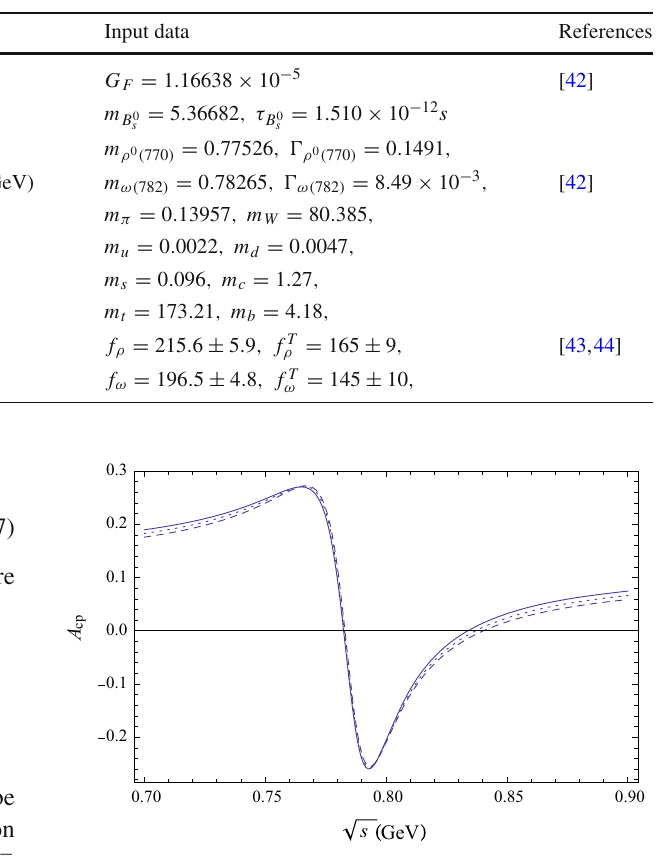
Fig. 1 The CP violating asymmetry, A cp , as a function of ferent CKM matrix elements. The dash line , dot line and solid line corresponds to the maximum, middle, and minimum CKM matrix ele- ment for the decay channel of ¯ B 0 s → ρ 0 (ω)ρ 0 (ω) → π + π − π + π − ,